Question: Express in one sentence what the figure is showing.
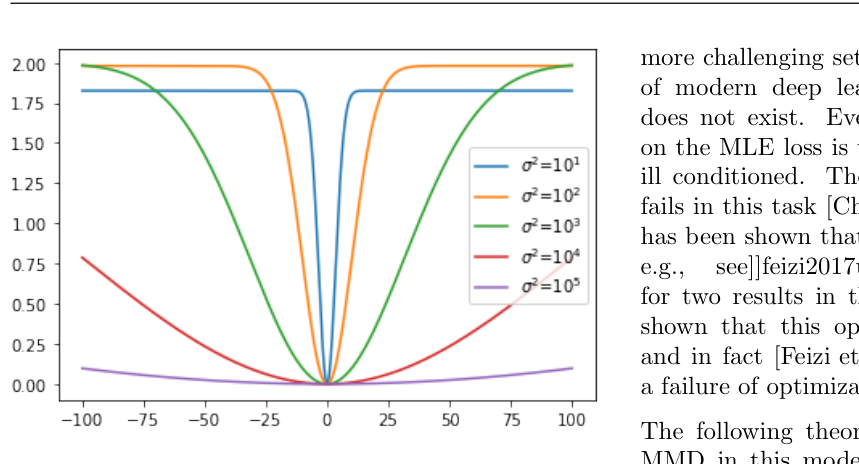
Answer: MMD loss of Gaussian over R with unknown mean. Different widths σ2 and µ∗= 0.